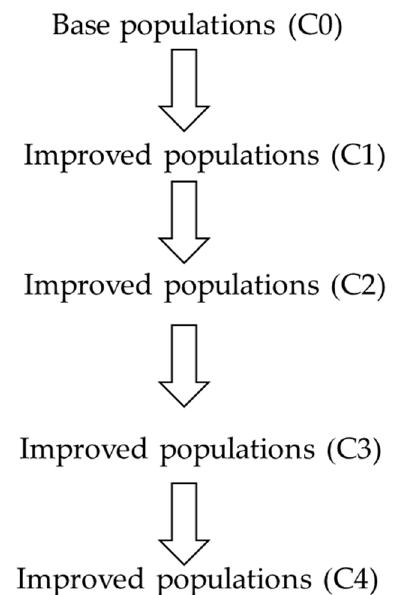
Figure 1. Schematic diagram for population improvement of five purple field corn populations through modified mass selection emphasizing purple husk and cob and orange kernels for four cycles in 2015 to 2017.